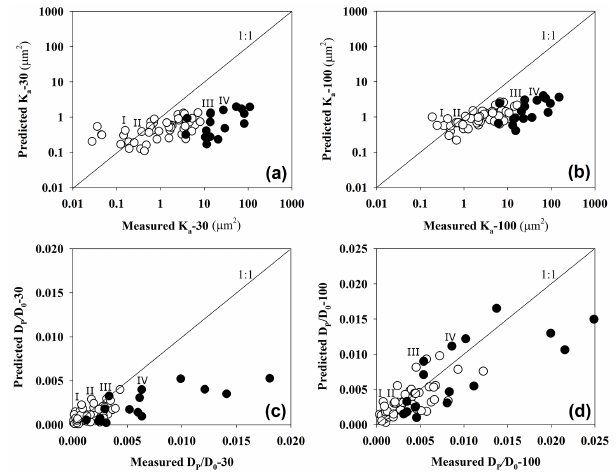
Figure 5. Predictive performance of empirical models for air per- meability ( K a ) and gas diffusivity ( D P /D 0 ) at − 30 and − 100cm matric potentials. (a, b) Chamindu Deepagoda et al. (2011) model; (c, d) WLR–Marshall model (Moldrup et al., 2000). Filled symbols represent samples with biopore-dominated flow and empty sym- bols represent samples with matrix-dominated flow. Visualizations of samples marked as I, II, III, and IV are depicted in Fig. 3.